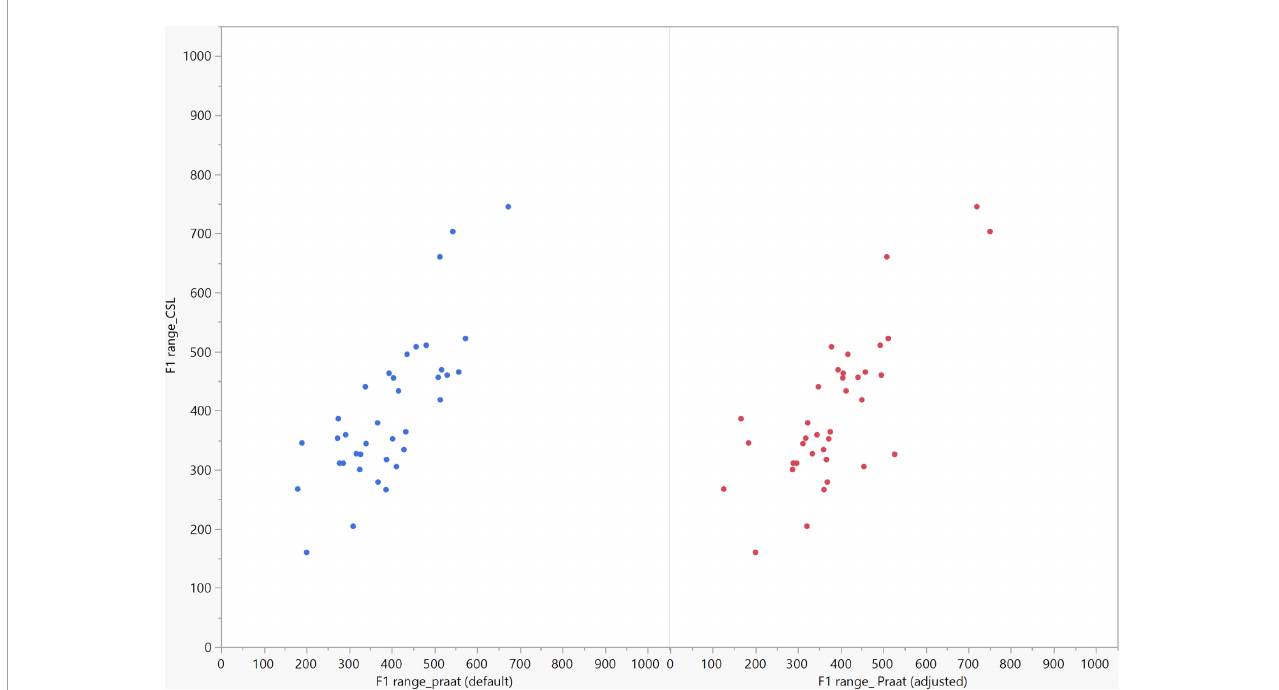
FIGURE9 Correlation between the F1 ranges of five vowels calculated from Computerized Speech Lab (CSL) F1 data and Praat F1 data using the default and adjusted settings. The calculated F1 ranges were highly correlated between CSL and both Praat settings (default settings: rs = 0.752, p < 0.0001*; adjusted settings: rs = 0.708, n = 37, p < 0.0001*).